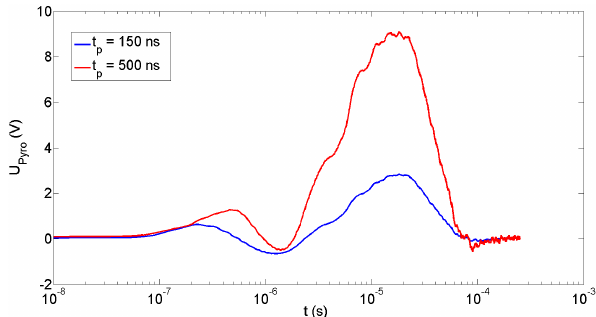
Figure 6. Time dependence of the output voltage of the current amplifier (10 8 VA − 1 , 7kHz bandwidth) for the PZT plate for an optical power of 22.5W and a pulse width of 150 and 500ns, re- spectively.